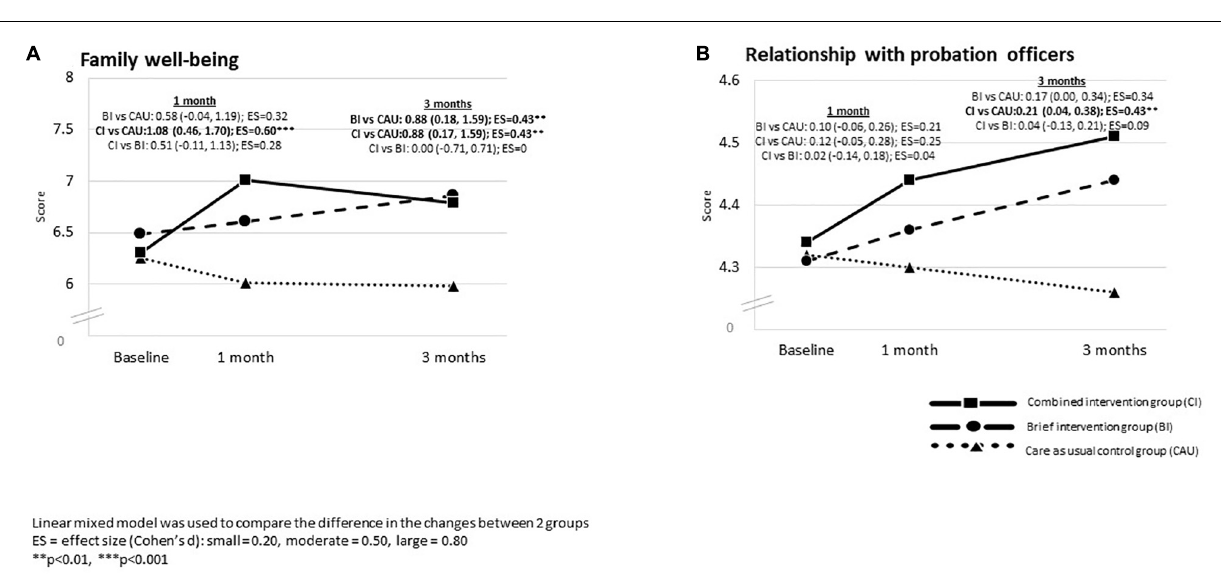
FIGURE 5 | The between–group difference in the changes in family well-being and relationship with probation officers at 1- and 3-month follow-up in three groups: Intention-to-treat